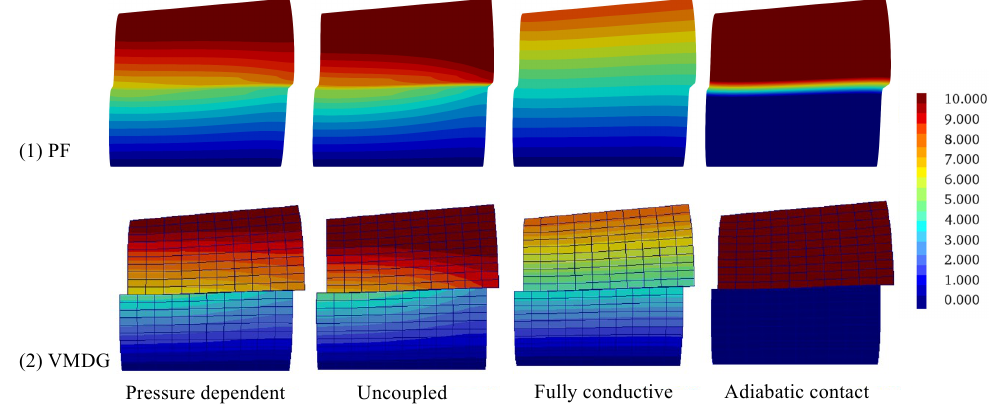
Figure 11. Temperature contours of four different thermal models for ( 1 ) the proposed phase field method and ( 2 ) the VMDG method in the deformed